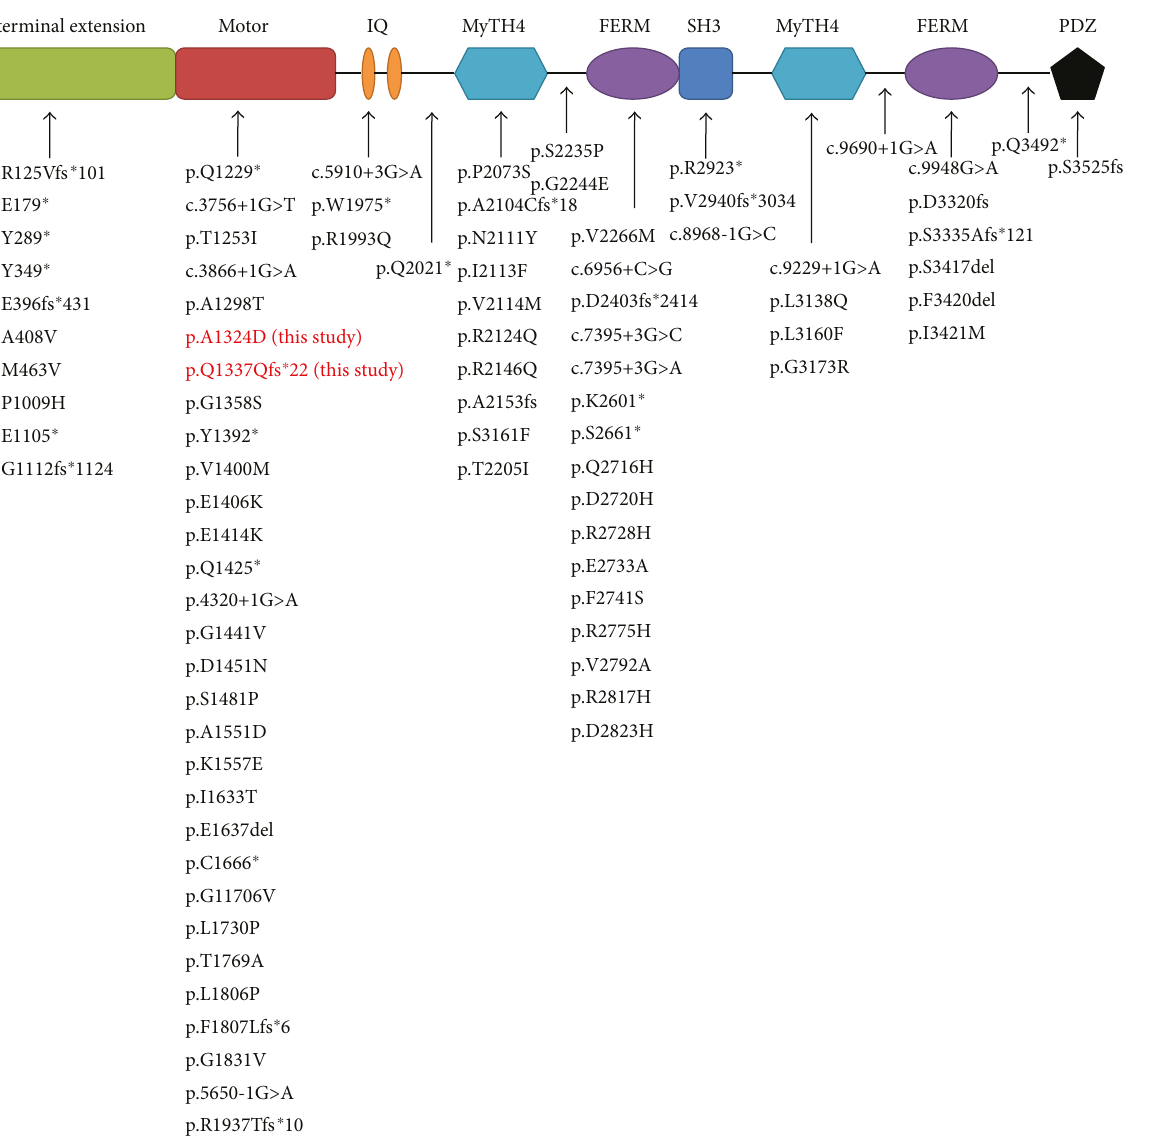
Figure 4: Reported mutations of MYO15A gene and their locations in the protein structure. The red characters refer to novel mutations identi fi ed in this